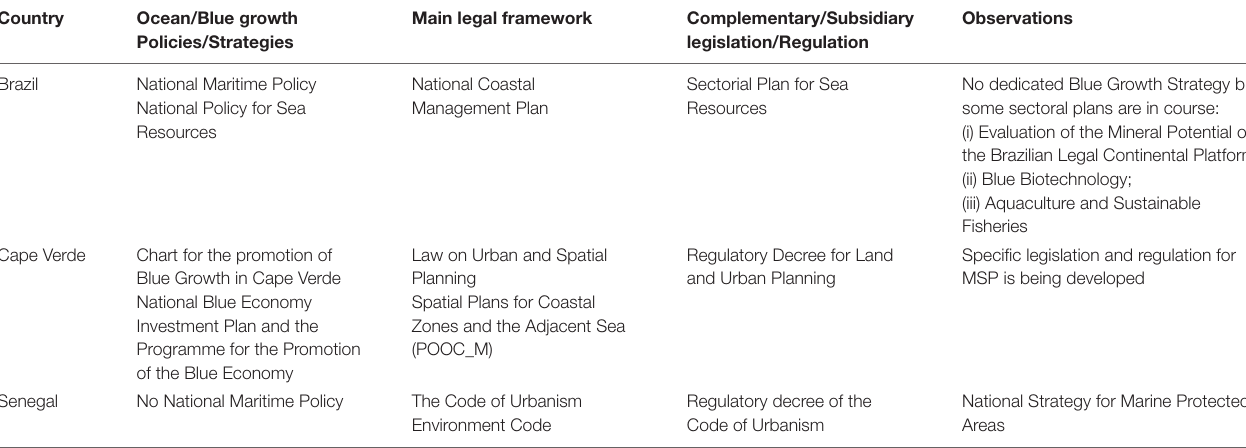
TABLE 4 | Legal framework for blue growth and maritime space governance in Tropical Atlantic case